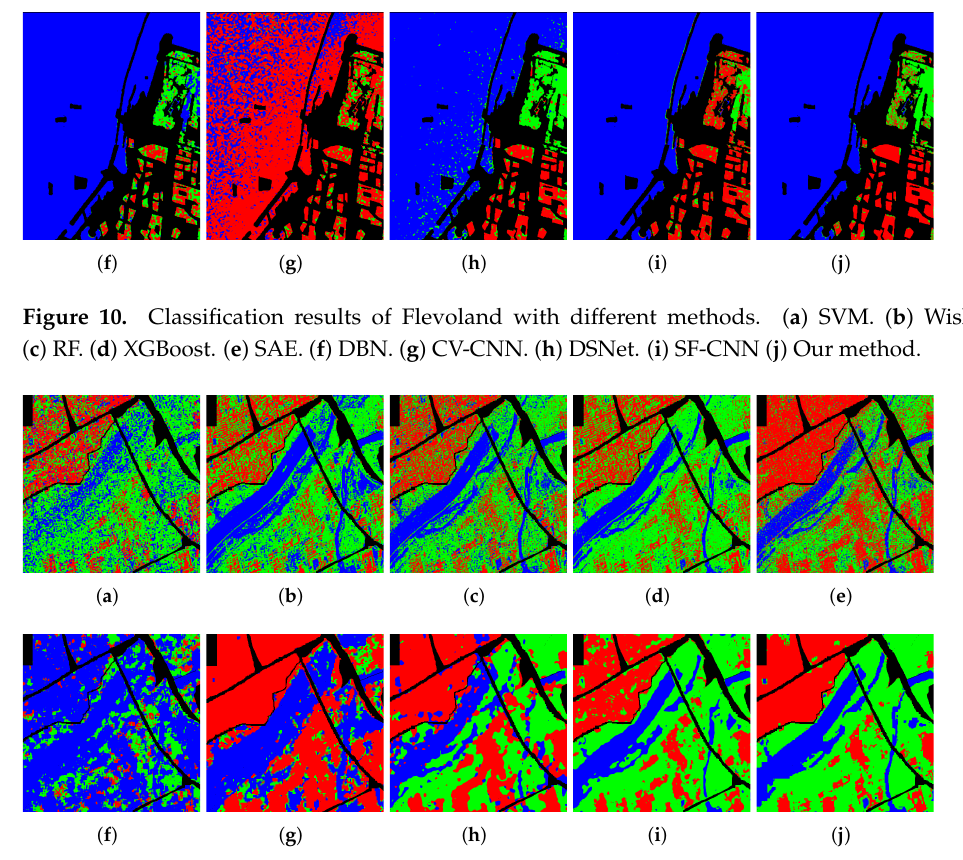
Figure 11. Classification results of Xi’an with different methods. ( a ) SVM. ( b ) Wishart. ( c )